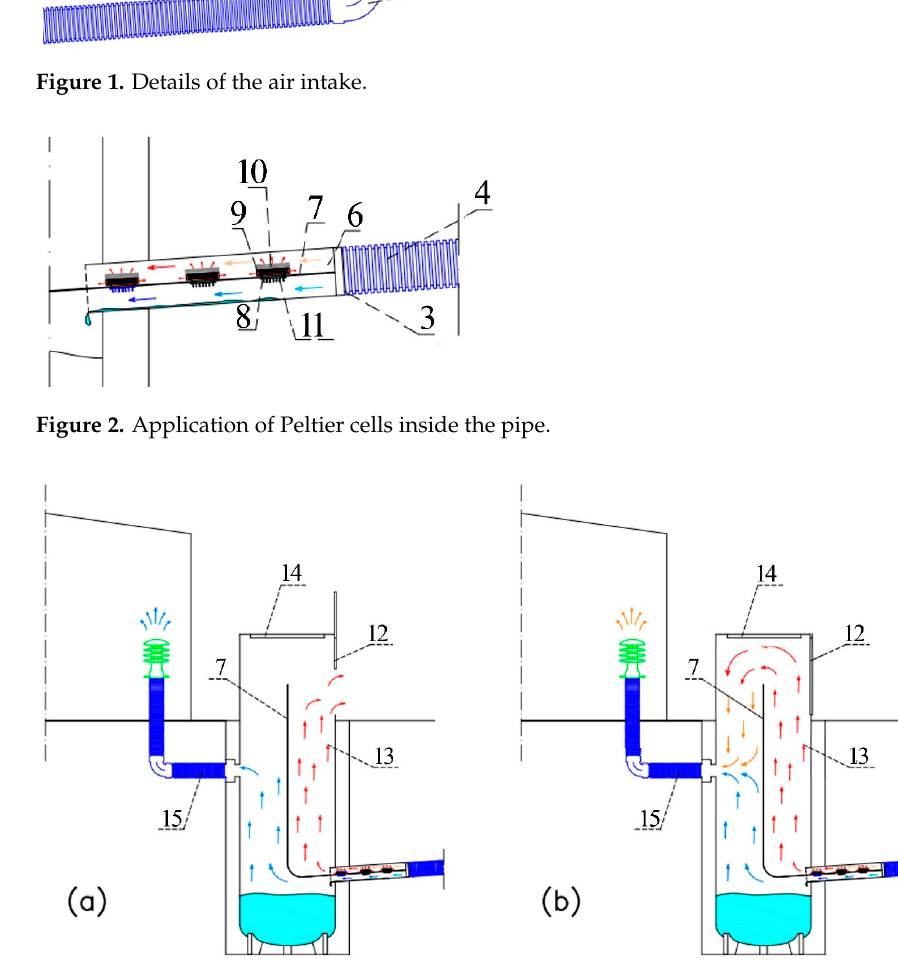
Figure 3. Tank for water collection: open grille ( a ) and closed grille ( b ).